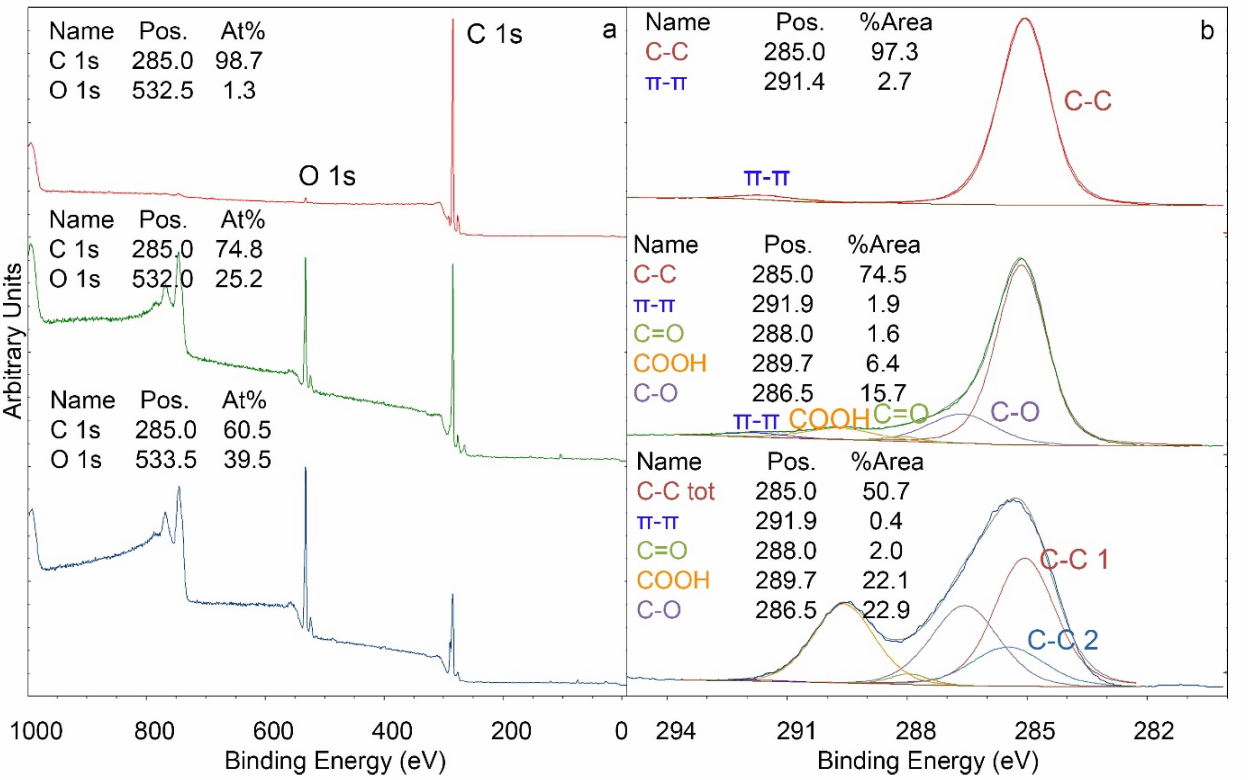
Figure 2. XPS data before (red curve) and after oxygen plasma treatment (green curve), and after acrylic acid grafting (blue curve). ( a ) Survey spectra, ( b ) high-resolution scan of the C 1s signal. C–C tot corresponds to the sum of C–C 1 and C–C 2. The spectra were normalized (min to